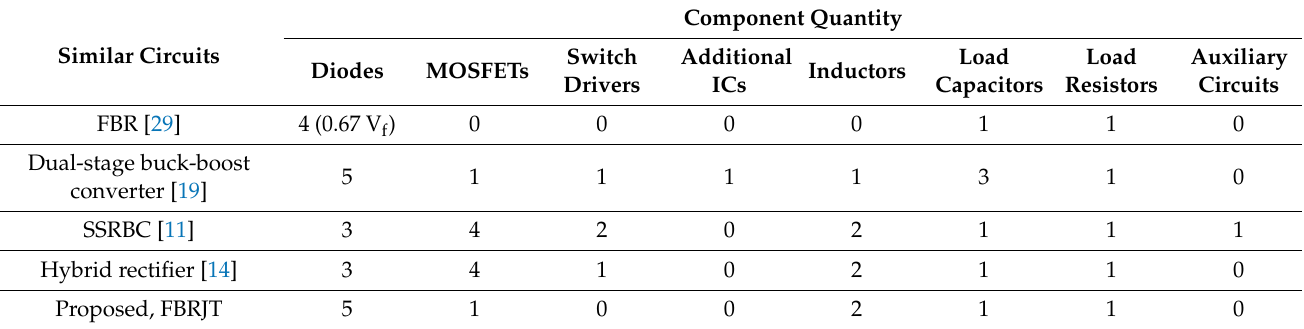
Table 1. List of eliminated parameters in the proposed